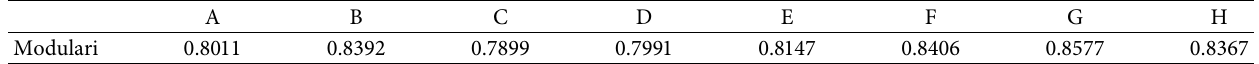
Table 4: Modular indicators of professional